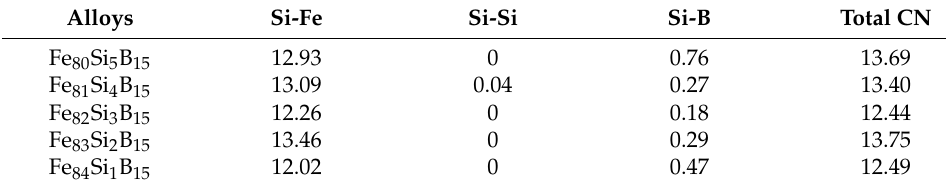
Table 3. Si-centered total and partial CNs in the Fe 80+x Si 5 − x B 15 ( x = 0–4) alloys. Alloys Si-Fe Si-Si Si-B Total CN